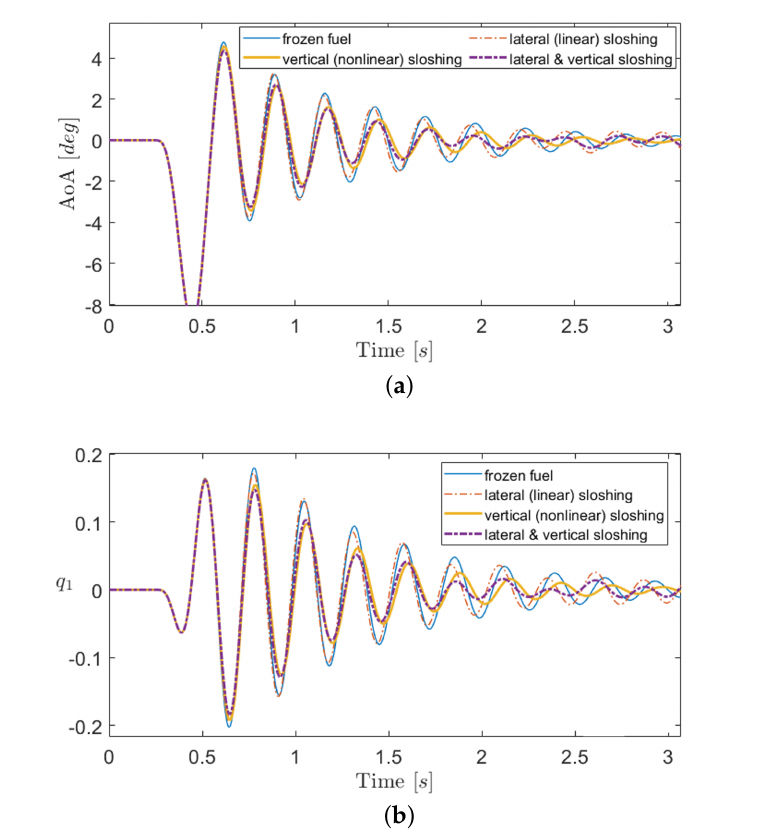
= 2.5m/s—Test Case 1. ( a ) Local angle of attack. ( b ) First a